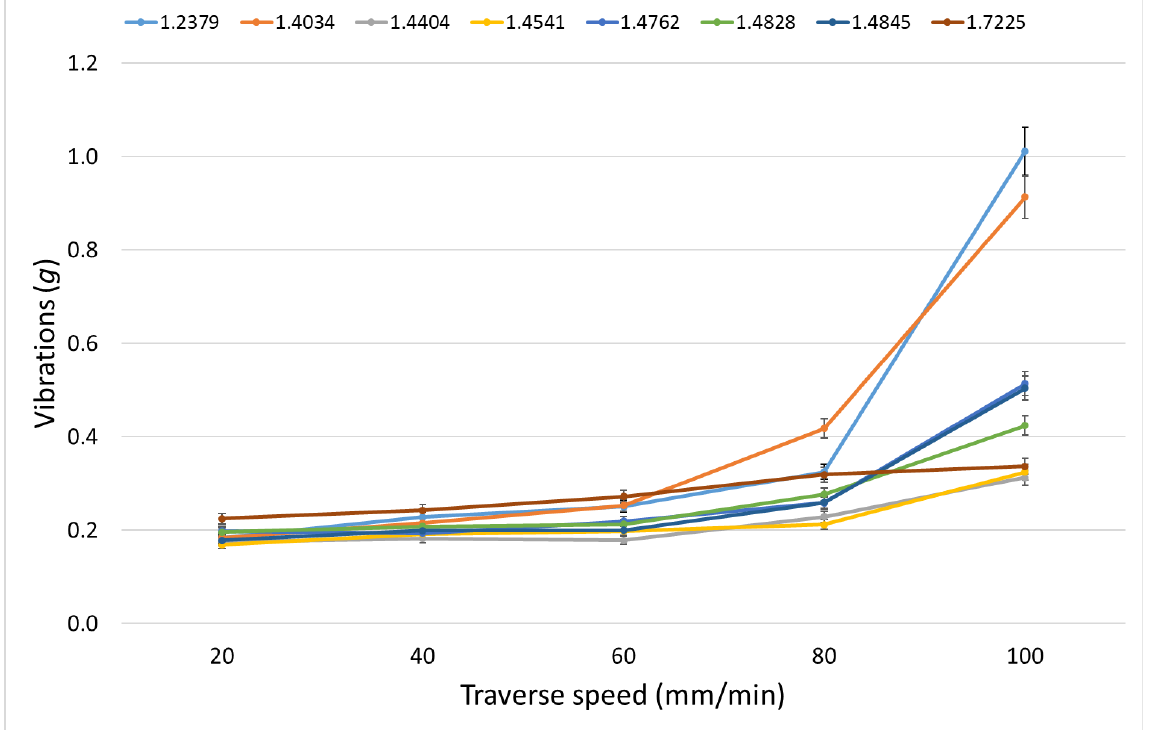
Figure 10. Vibrations in the z -axis on selected steels for tested traverse speeds.